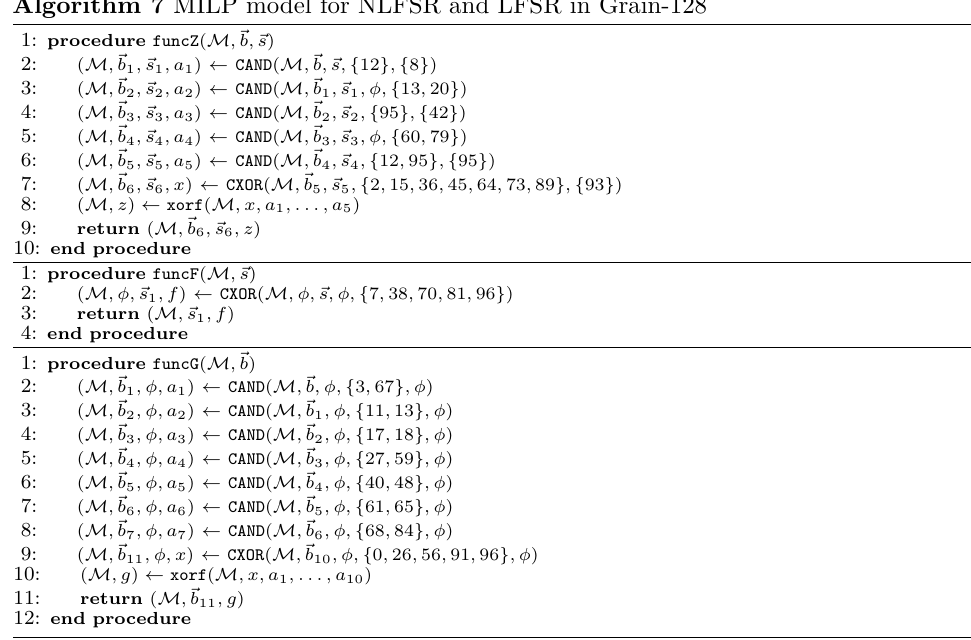
Algorithm 7 MILP model for NLFSR and LFSR in